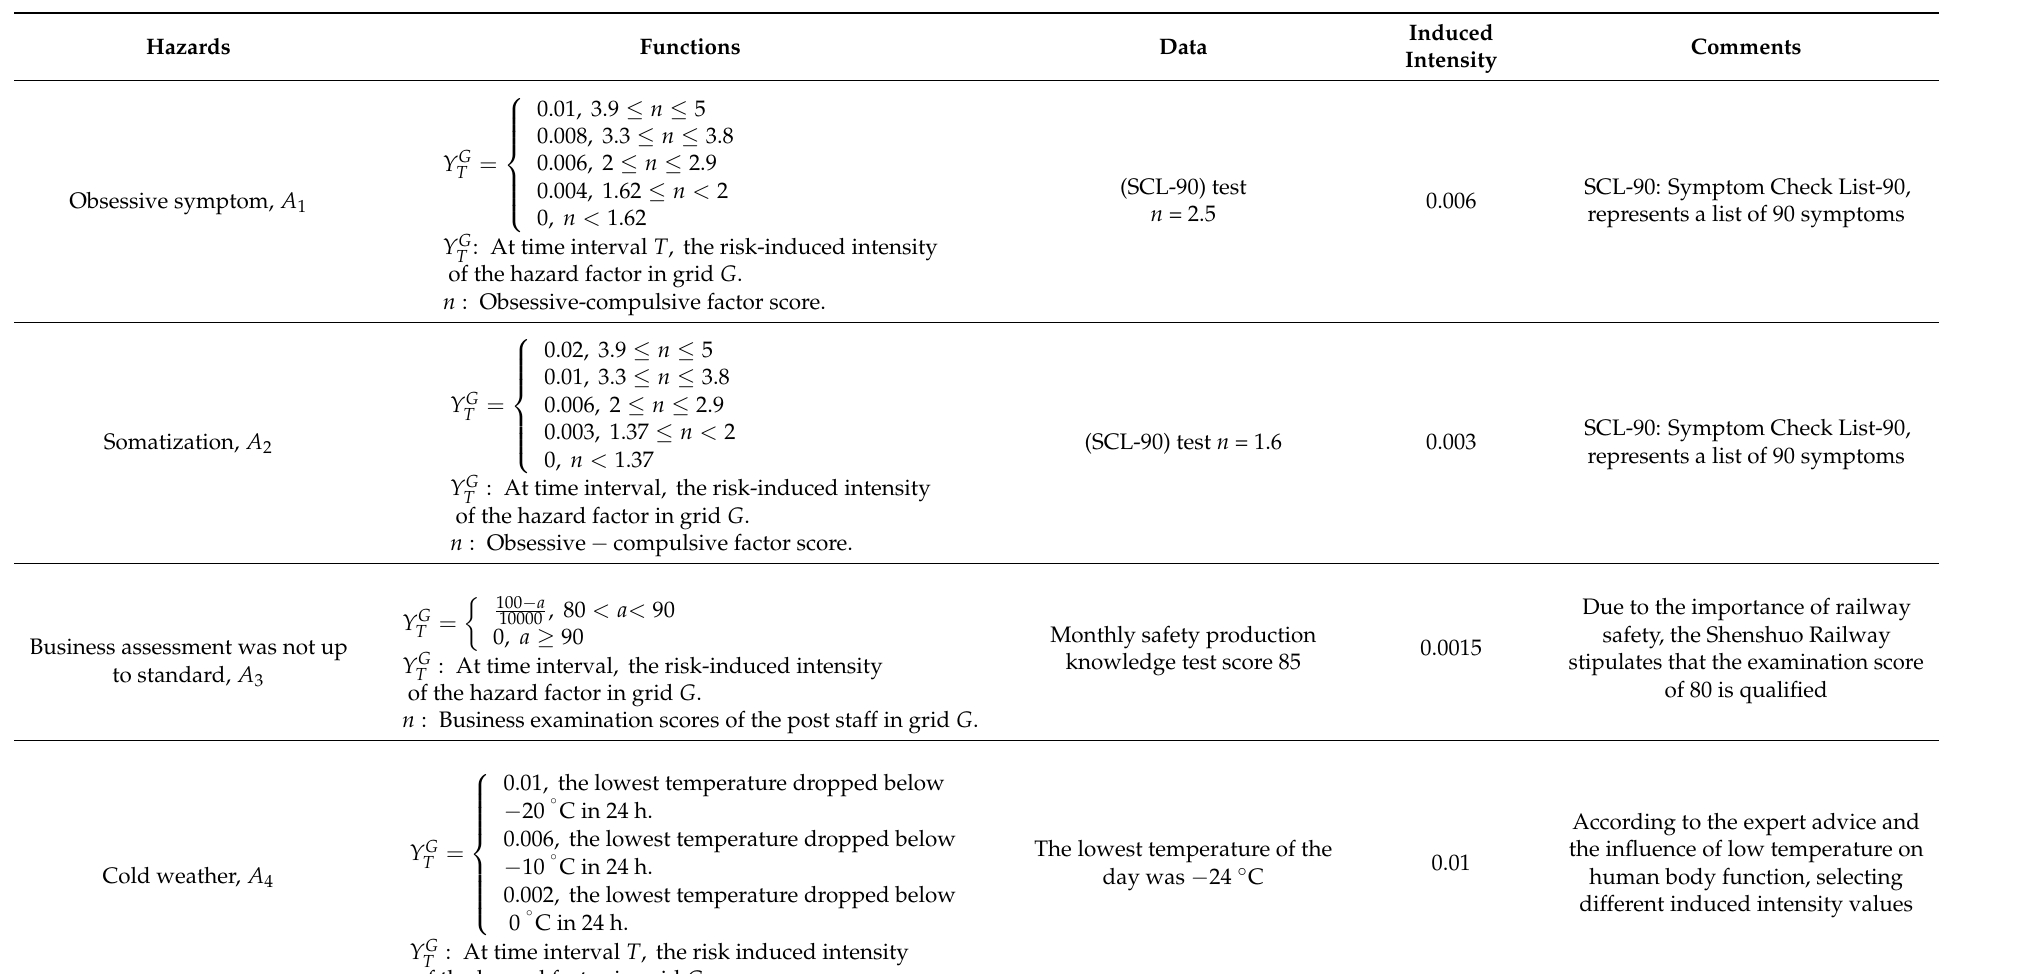
Table 11. Hazard factor data set of “the assistant watchman did not appear as required”